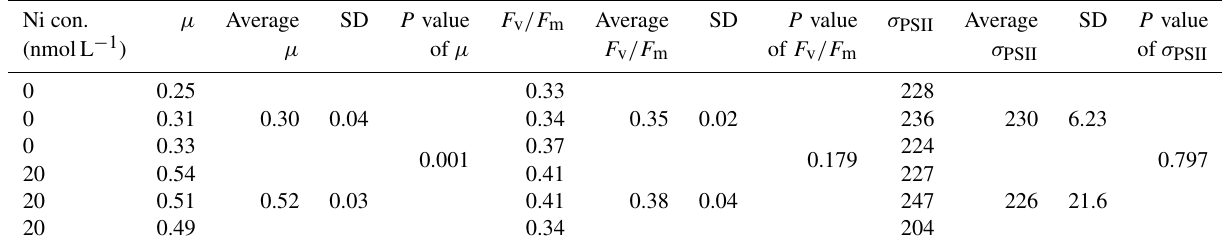
Table 3. Physiological responses of Synechococcus sp. (CS-205) at two different Ni concentrations with three replicates each treatment (shown individually). Ni con. is the total dissolved Ni concentration in the media. µ means growth rate (d − 1 ). SD means standard deviation. P value was calculated using t test. The unit of σ PSII is nanometers squared (nm 2 ) per reaction center (RC). Ni